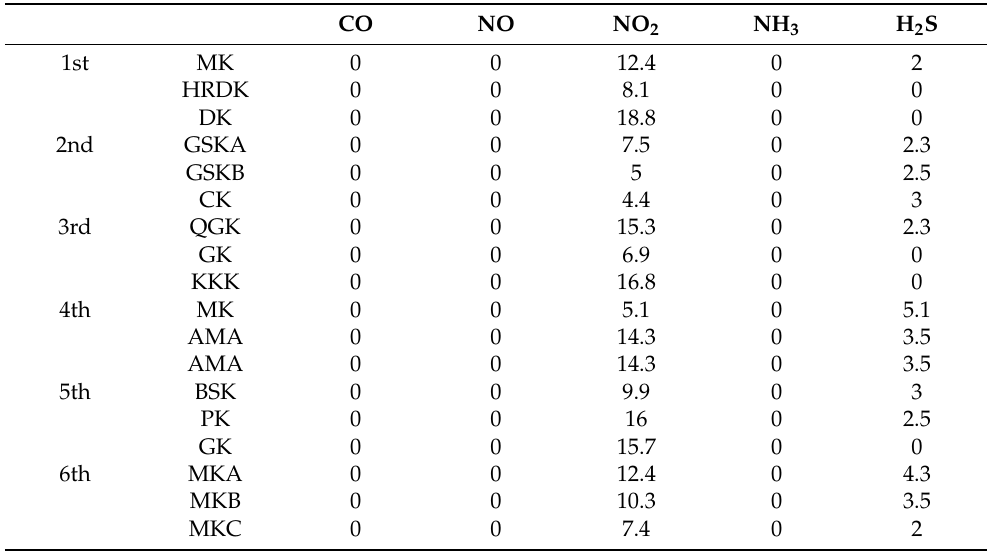
Figure 2. The sampling sites PM 10 , PM 2.5 , and PM 1 . Note: red color (PM 10 ); orange color (PM 2.5 ); red color (PM 1 ). Table 3. The concentrations of CO, NO, NO 2 , NH 3 , and H 2 S in the sampling sites. Quadrates sampling site. Concentration of other parameters (mg/L).